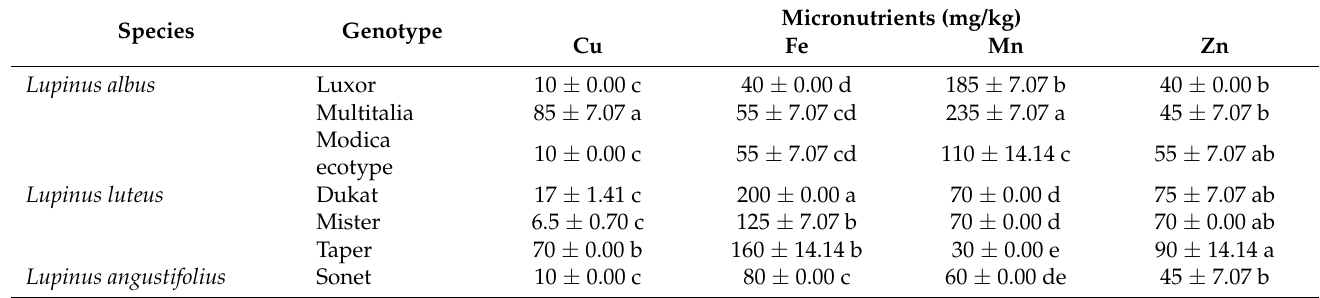
Table 1. Content of micronutrients in different Lupinus spp. genotypes.